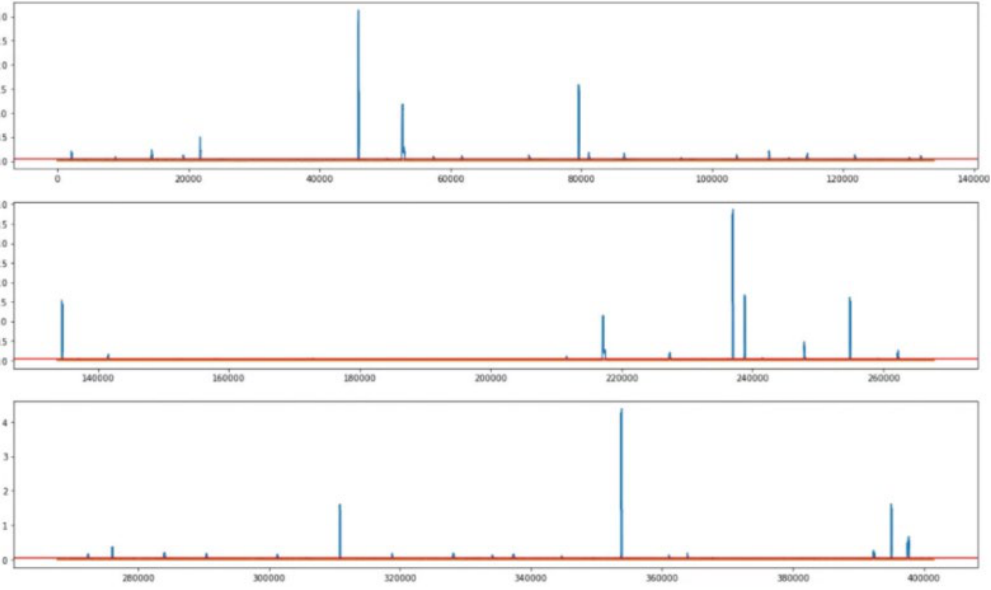
Figure 9. Average of differences produced by the entire field (blue)/threshold (red). The blue line is the average of the differences calculated by the entire field to determine if there is an attack. The red line is a value arbitrarily specified by the experimenter, and if the blue line exceeds the red line, that point is predicted to be an attack. Table 9. Performance metrics according to the threshold of each